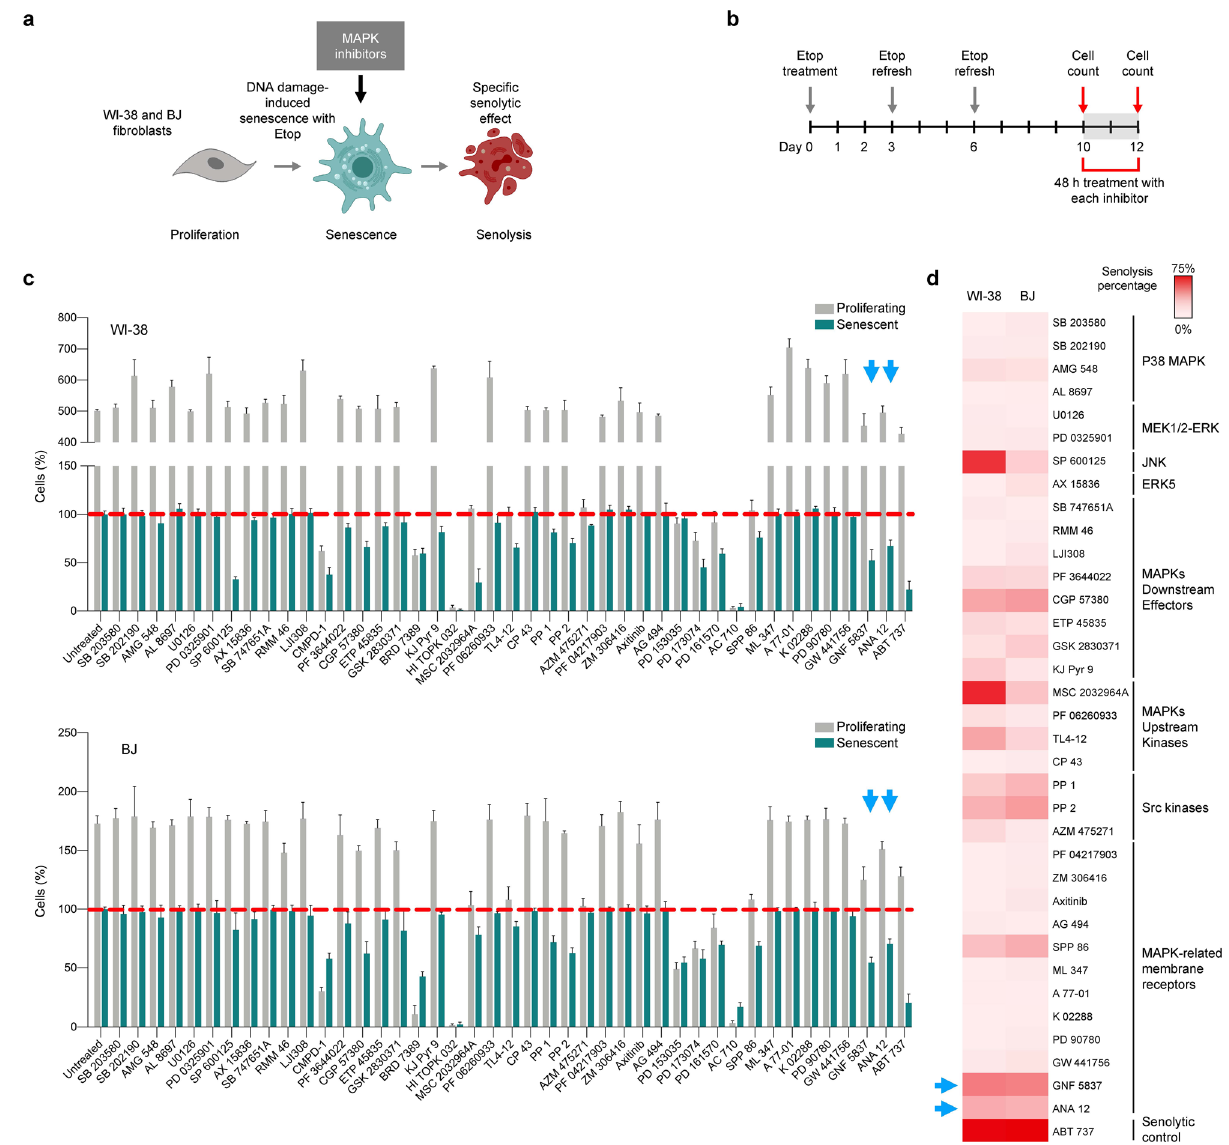
fi broblasts (top graph) and BJ fi broblasts (bottom graph) after treatment with the druglibraryfor48h(day12)relativetothetimebeforedrugaddition(day10).Red line, percentages of cells present at each condition right before starting the treat- mentsatday 10.Allthedrugswereadded at a concentration of 10 μ M. d Heat map representingthepercentageofsenolysis(percentageofcelldeath)after48hwhen comparing day 12 to day 10 in senescent cells. Drugs were grouped by the target proteins inhibited within the MAPK superfamily. Graphs in c represent the mean values ±SD of n =3 experiments. See also Supplementary Fig.